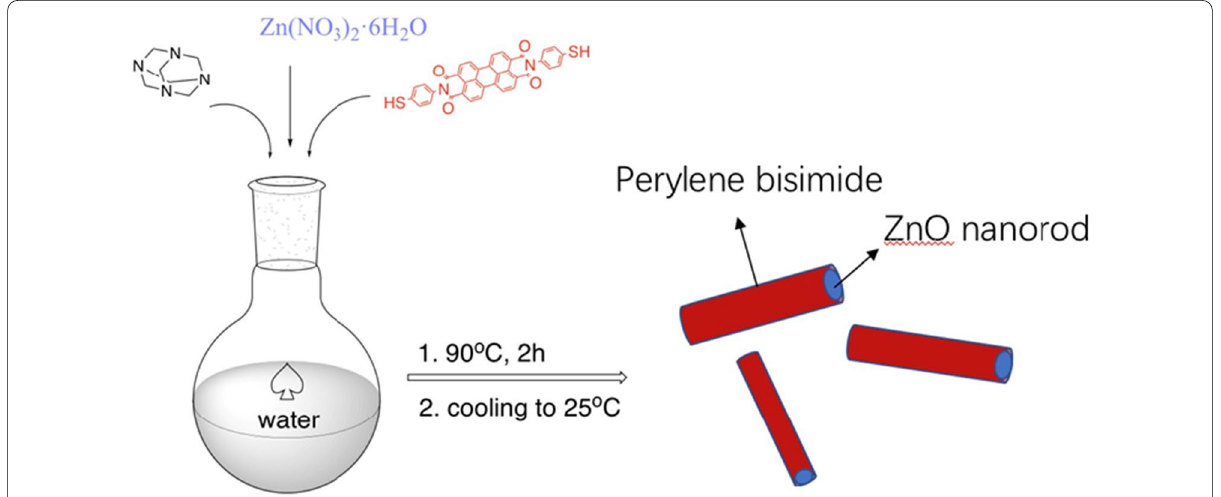
Fig.1 In-situ ZnO nanocrystals growing reaction in the T-PTCD solutions